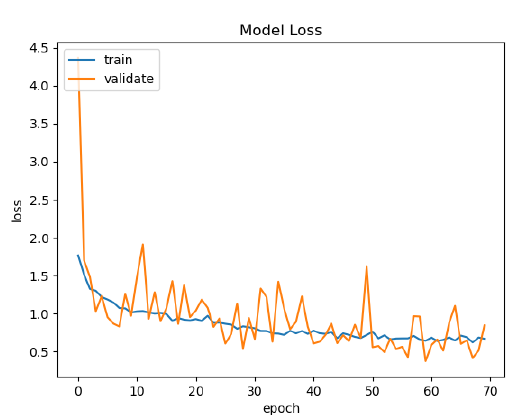
Figure 15. VGG-Unet Acc.